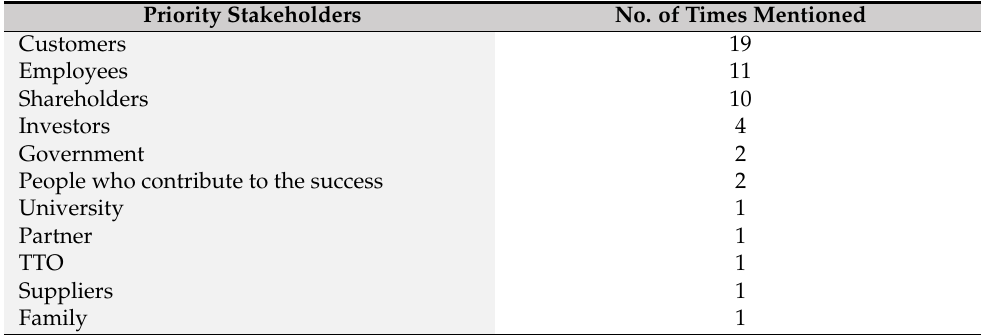
Table 9. Priority stakeholders according to the USO respondents.